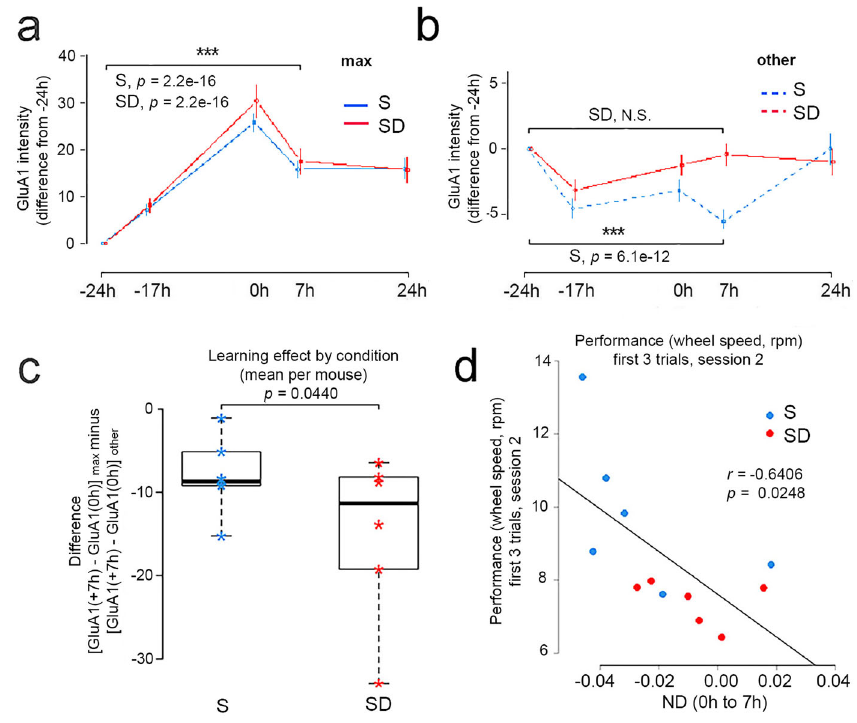
Fig. 4 Post-training changes in max and other spines. a SEP-GluA1 intensity in max spines (difference from − 24h) across all time points (mean ± SEM). The max spines are de fi ned as those that showed the largest increase from − 24 h to 0 h (max spines as % of all spines = 13.5 ± 4.1%, 207/1530; mean ± sd; range per mouse = 6.3 – 20%; see also Supplementary Fig. 6). These spines maintain high SEP-GluA1 levels at later times (7 h vs − 24 h; p = 2.2e − 16 in both groups). S, sleep ( n = 6 mice); SD, sleep deprivation ( n = 6 mice). b SEP-GluA1 intensity in the other spines (difference from − 24 h) across all time points (mean ± SEM). Note the different scale of the Y axes in ( a , b ). During the 7 h after the fi rst training session, the other spines of S mice show a decrease at 7 h vs − 24 h ( p = 6.1e − 12), while the other spines of SD mice do not (7 h vs − 24 h, N.S.). In a , b statistical analysis was performed using linear mixed effect models, with session as a categorical fi xed effect, and spine, dendrite and mouse as random effects. A likelihood ratio test was used to check for an effect of session. S, sleep (6 mice); SD, sleep deprivation (6 mice). c The difference between the change in SEP-GluA1 from 0 h to 7 h in the max spines and the change in SEP-GluA1 from 0 h to 7 h in all other spines. There is a signi fi cant effect of group (S or SD; likelihood ratio test, p = 0.0440), indicating an advantage for the max spines and a penalization of all other spines in the S group (6 mice) relative to the SD group (6 mice). Center line indicates the median, the box boundaries indicate the fi rst and third quartiles and the whiskers indicate the minimum and maximum values. d Negative correlation between performance at the onset of session 2 ( fi rst 3 trials) and ND (normalized difference; mean ± SEM) in spine SEP-GluA1 expression in each mouse between 7 h (after S or SD) and 0 h (after training). All spines ( r = − 0.6406; two-sided Fisher ’ s z transformation, p = 0.0248). Negative ND values (net decrease in SEP-GluA1 expression) are associated with better performance. S, sleep (6 mice); SD, sleep deprivation (6 mice). Rpm, revolutions per minute. Source data are provided as a Source data fi (Fig. 4b). To further test the hypothesis that max spines remain the mean effects, we fi tted an LME model with time (7 h and 24 h), learning, and their interaction as fi xed effects, and dendrite as time and learning (Supplementary Table 3), indicating that the